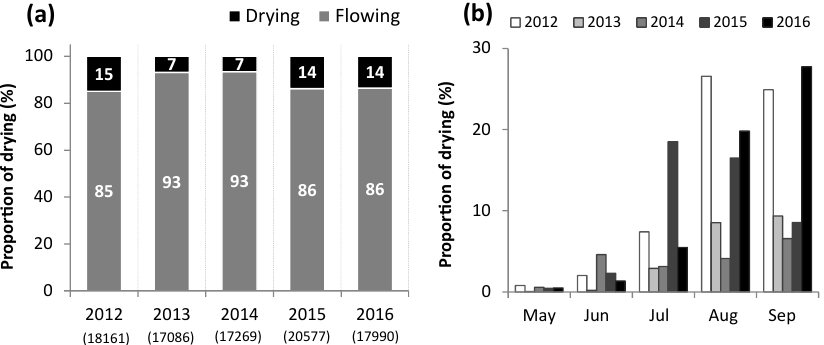
Figure 4. (a) Distribution of the yearly proportion of drying observed with the ONDE network with the total yearly number of ONDE observations written in brackets and (b) distribution of proportions of drying per year and per month.